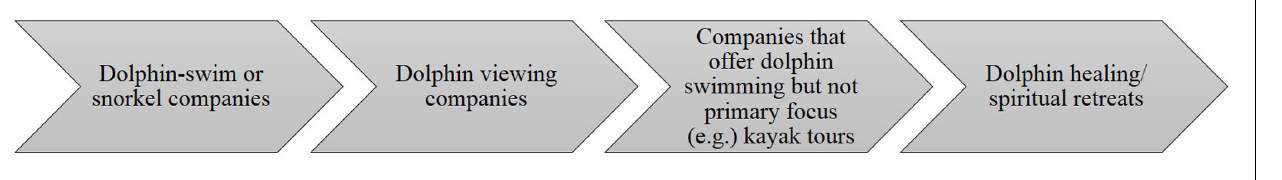
FIGURE 1 | Four dolphin operator